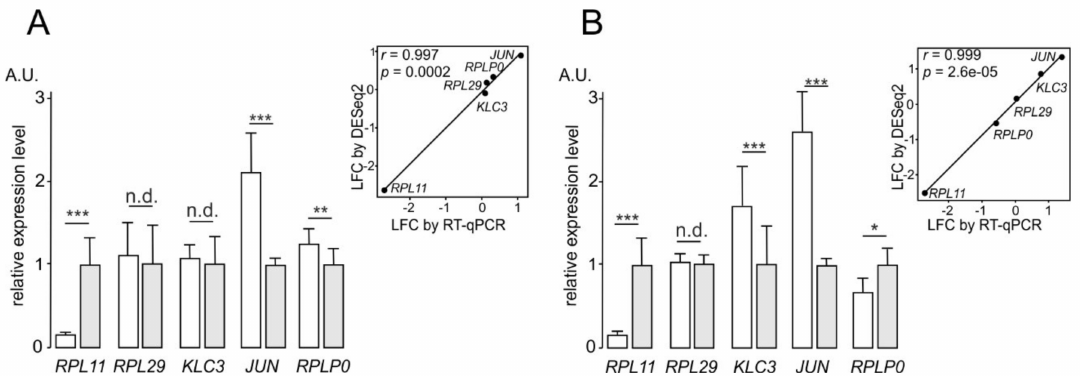
Figure 3. Validation of the results of the differential gene expression analyses with the RNA-seq and polysome profiling followed by RNA-seq (Poly-seq) data by RT-qPCR. The relative levels of mRNAs for the group of selected DEGs and reference genes found in total RNA samples ( A ) and in RNA samples from the respective polysome fractions ( B ) from uL5 knocked down HEK293T cells and control cells. The data are presented as the mean of arbitrary units (A.U.) from three or more replicates ± SEM (* p < 0.05, ** p < 0.01, *** p < 0.001 (Mann–Whitney test), n.d., no difference), displayed as dark and light columns for uL5 knocked down and control cells, respectively. Graphs showing the correlation between the RNA-seq and Poly-seq data and the RT-qPCR data are presented in